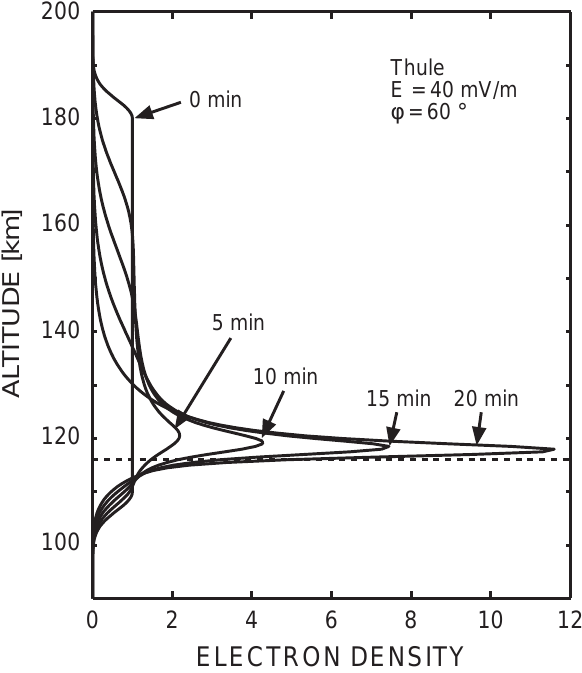
Fig. 2. Time development of layer generation at Thule at 5-min intervals. The initial Fe + ion density profile is denoted by 0 min. The altitude of the convergent null in the vertical ion velocity profile is denoted by the dashed